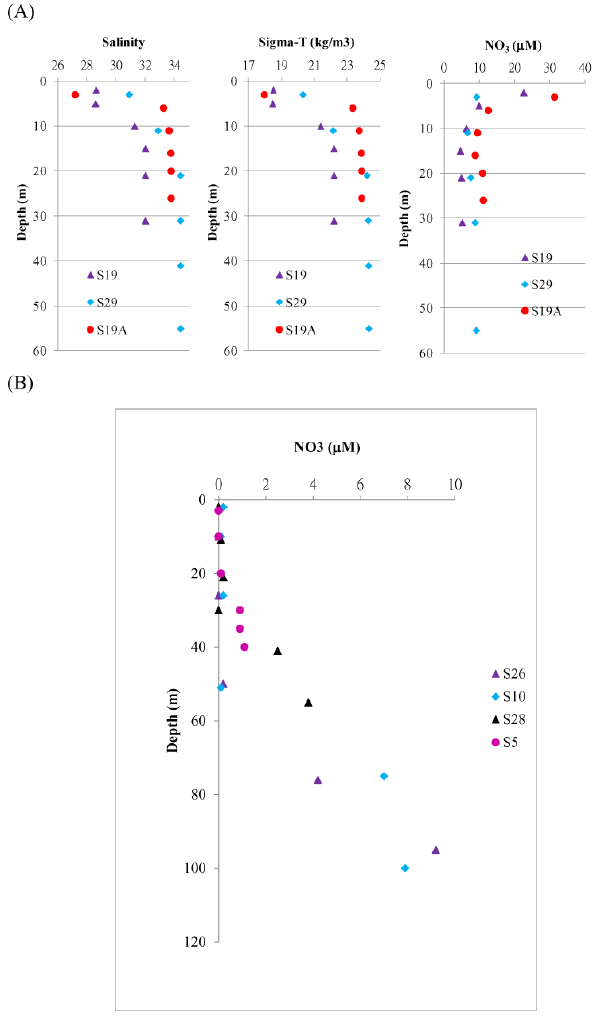
Fig. 6. (A) Distributions of salinity, sigma- T and nitrate in the in- ner shelf stations S19, S19A and S29. (B) Distributions of vertical nitrate (S26, S28, S10 and S5) in the East China